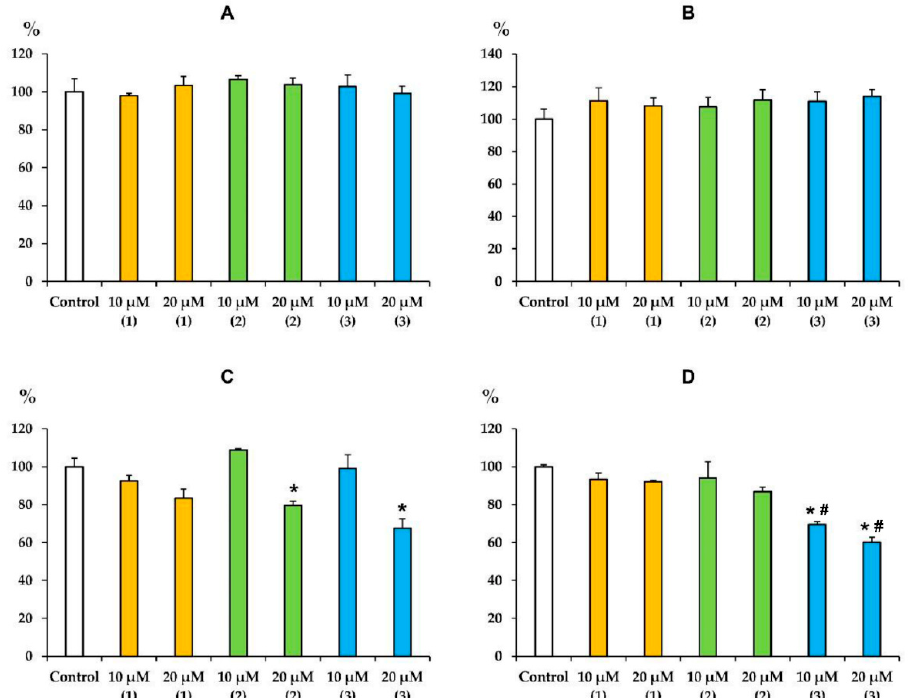
Figure 2. Effects of modified levopimaric acid diene adducts on the activity of complexes of the mitochondrial respiratory chain (values in % of activity compared with control). In the absence of conjugate (control), the activities of complexes I (panel A ), II (panel B ), III (panel C ) and IV (panel D ) were 365 ± 11, 412 ± 12, 679 ± 9 and 477 ± 4 nmol/min/mg protein, respectively. The activity values in the absence of conjugate were taken as 100%. The results are presented as means ± SEM ( n = 4). * p < 0.05 (versus control), # p < 0.05 (versus corresponding concentrations of compounds 1 and 2 ).